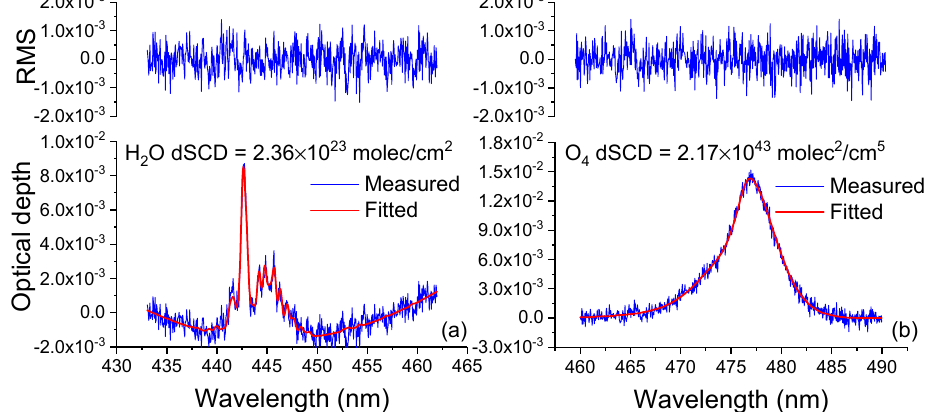
Figure 2. Spectral proofs for the detection of H 2 O ( a ) and O 4 ( b ) at 07:48 UTC (SZA: ~47.2 ◦ ) with an elevation angle of 10 ◦ on 19 June 2018. The blue and red lines represent the measured spectra and the fitted reference cross sections, respectively. Table 1. DOAS retrieval settings for O 4 and H 2 O.